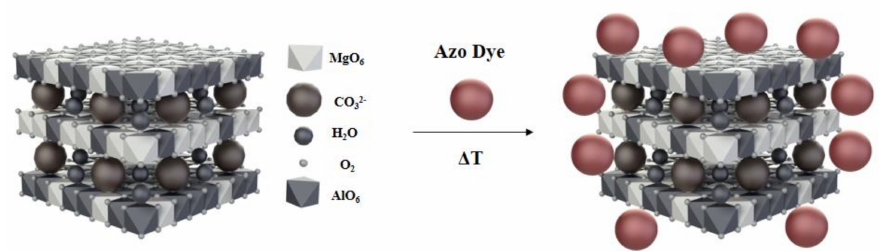
Figure 5. Possible structural arrangement of azo chromophore in AlMg − LH